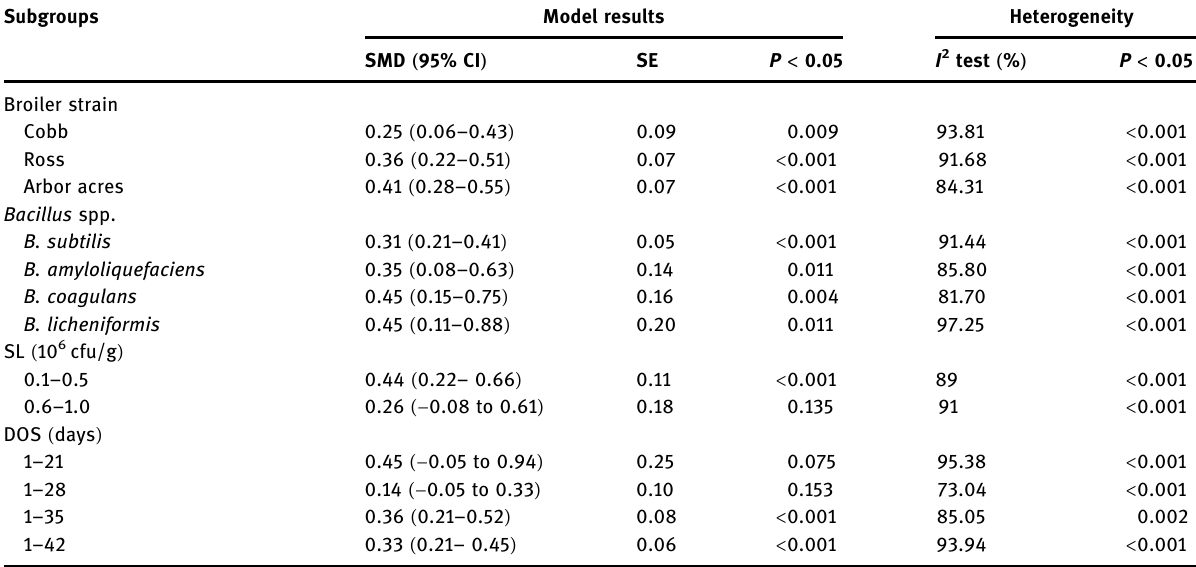
Table 4: Subgroup analysis of the e ff ect of Bacillus probiotics on ADG of broiler chickens Subgroups Model results